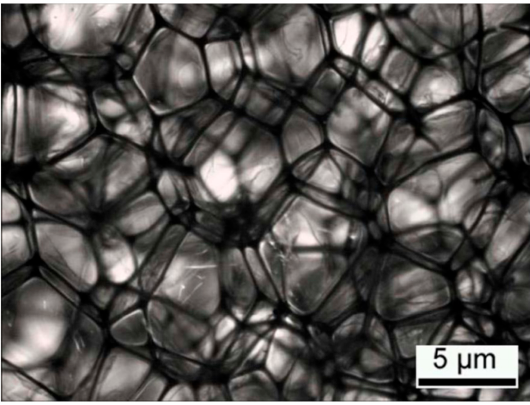
Figure 8. Optical stereoscope image, 25 mm thick sample with 30% and 2 DC.